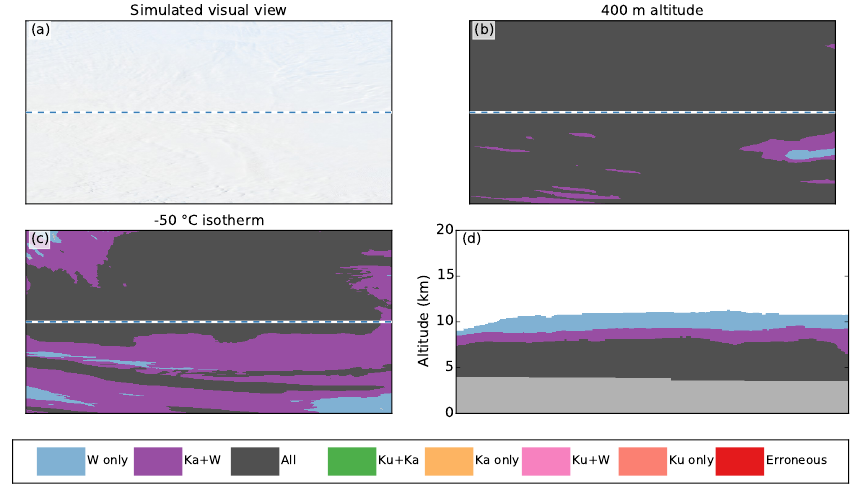
Figure 14. As in Fig. 6, but for the Antarctic snowfall (Sect. 5.6; ASF in Fig. 3), showing the − 50 ◦ C isotherm instead of 3 and − 15 ◦ C, and giving the vertical cross section in (d).